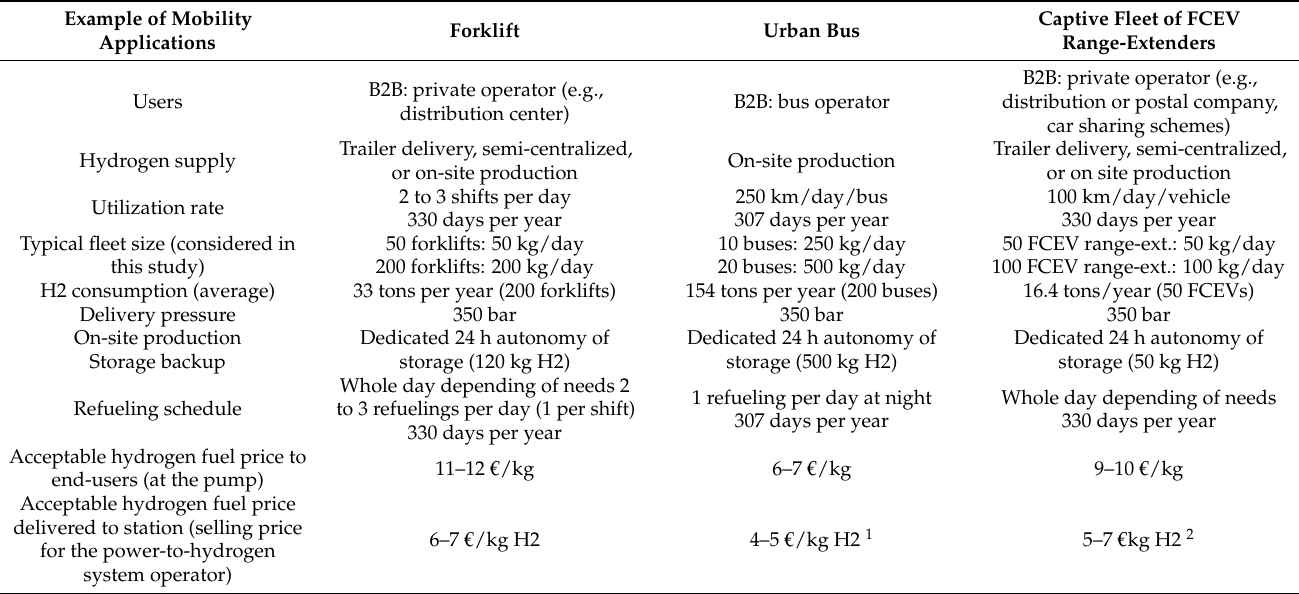
Table 13. Acceptable hydrogen prices to end-users and HRS operators per mobile application